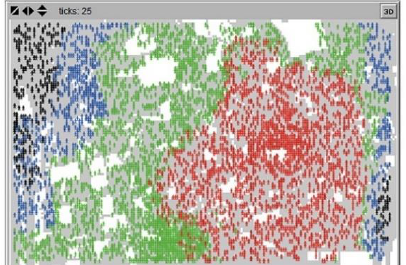
Figure 11-1: Segregation pattern resulting from satisfaction level of 20% in neighborhood radius 2